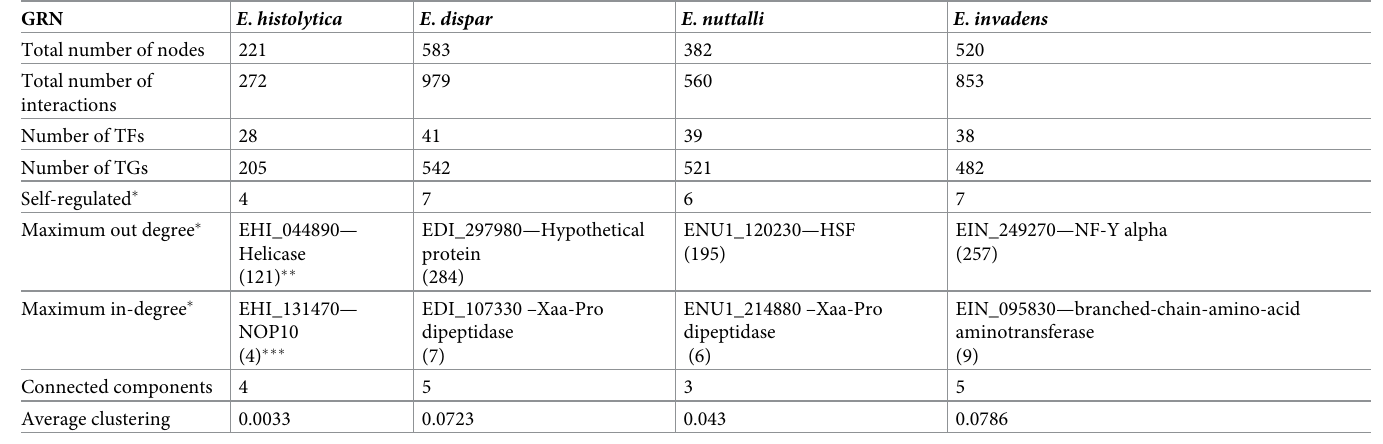
Table 1. General properties of the